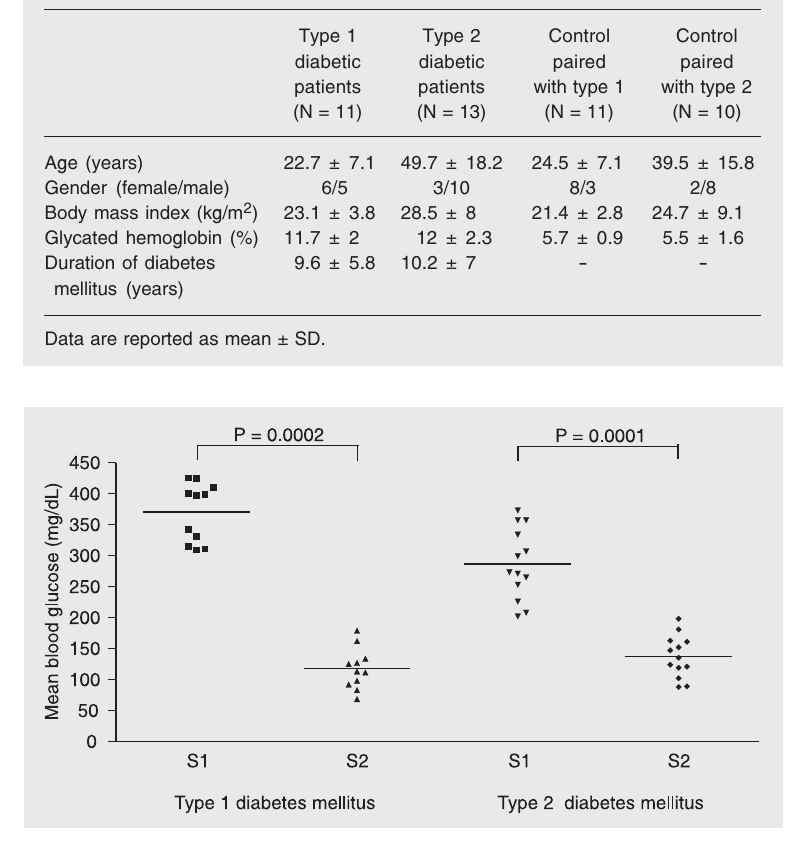
Table 1. Characteristics of type 1 and type 2 diabetic patients and healthy individuals paired with type 1 and type 2 patients.